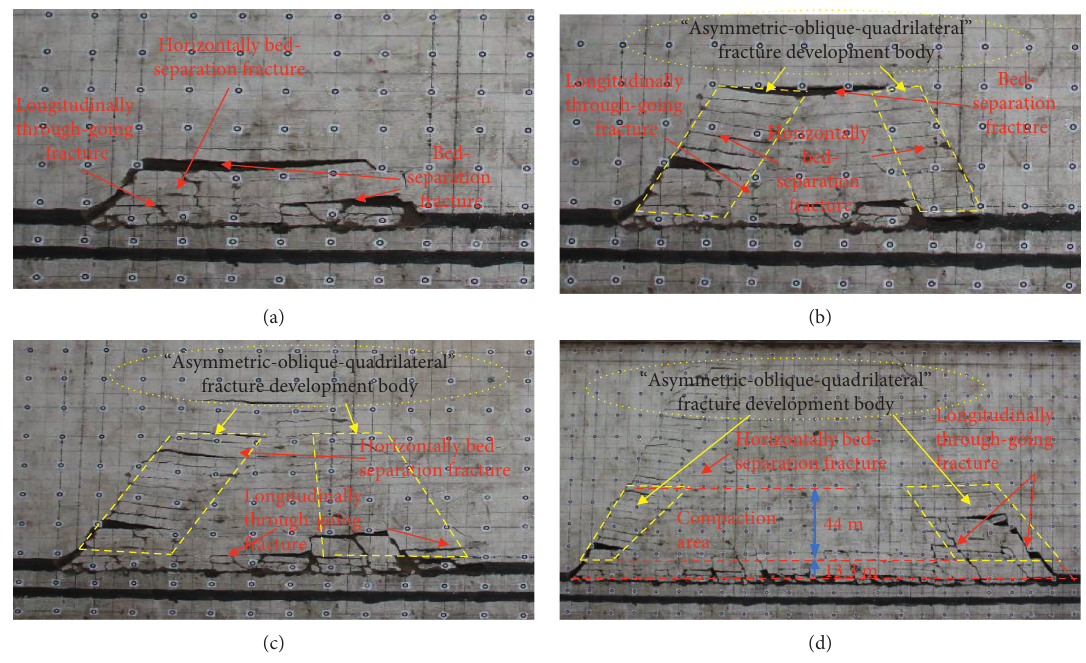
Figure 3: Fracture fields in overlying strata under different mining distances. (a) 70 m, (b) 100 m, (c) 110m, and (d) 180m.